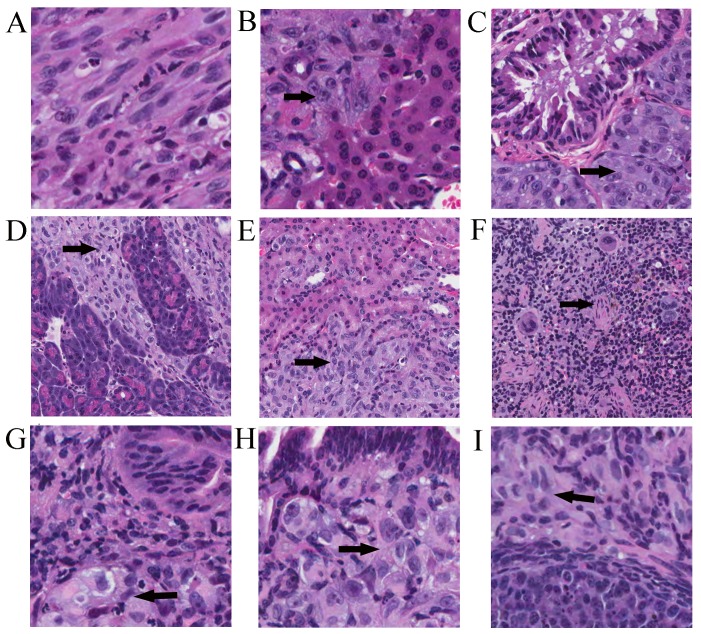
Pathological and histological features of primary tumors and metastatic tumors.A-I, the primary tumors (human xenografts) were formed by the subcutaneous injection of SK cells, and were metastasized to different organs. H and E staining reveals that the histological and pathological features of primary subcutaneous tumor cells (A), metastatic tumor cells (arrow) in liver (B), lung (C), pancreas (D), kidney (E), spleen (F), colon (G), uterus (H), and ovary (I). The tumors consisted of spindle-like shaped cells with ovoid or elongated nuclei containing 2 or more nucleoli per nucleus (A–I). Magnifications: 200 x